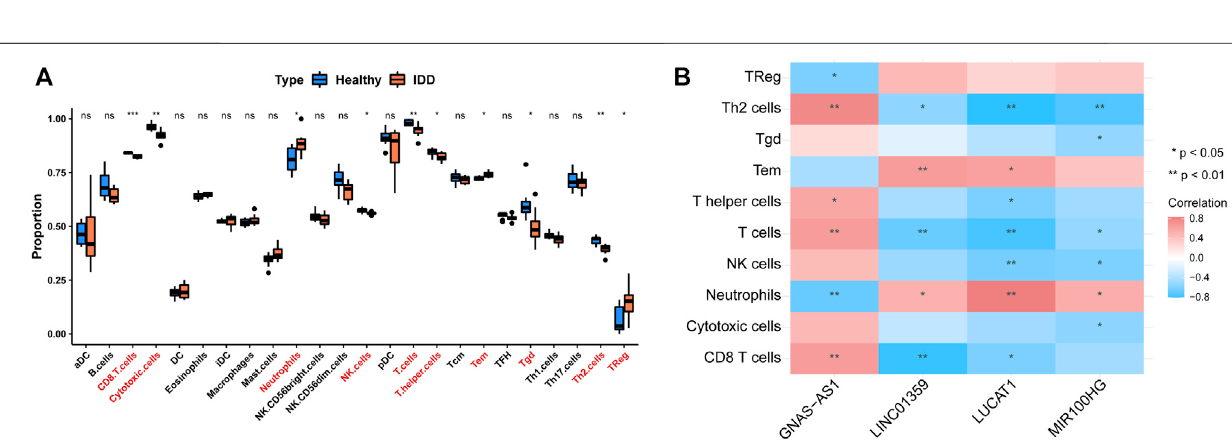
Frontiers in Genetics |